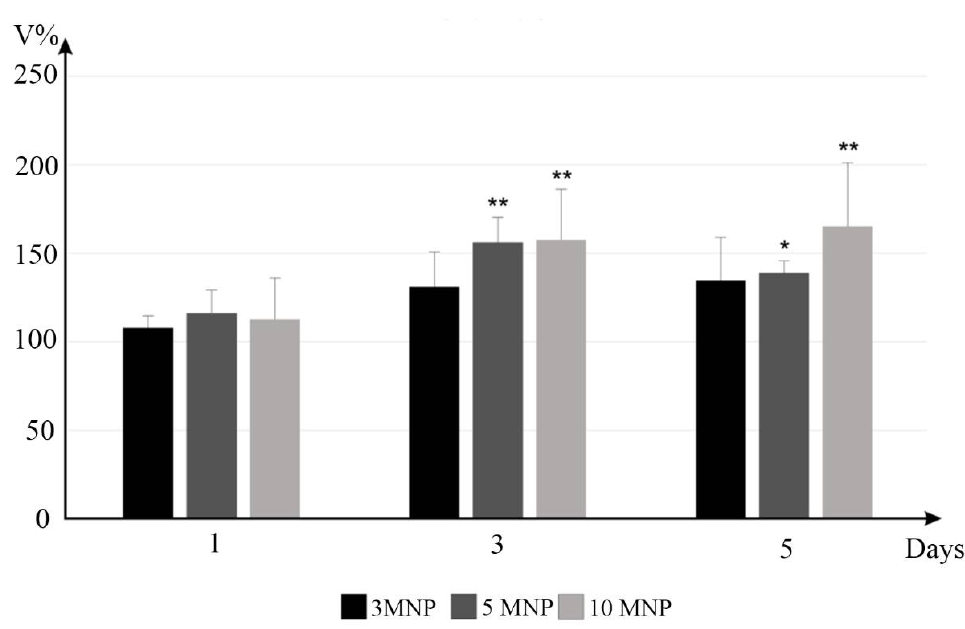
Figure 13. Viability of Hep-G2 cells over one, three, and five-days exposure to the magnetite enriched scaffolds, measured by MTT assay, data are represented as mean ± SD ( n = 3), asterisks indicate significantly different as compared with the control group (* p < 0.05 and ** p < 0.01).